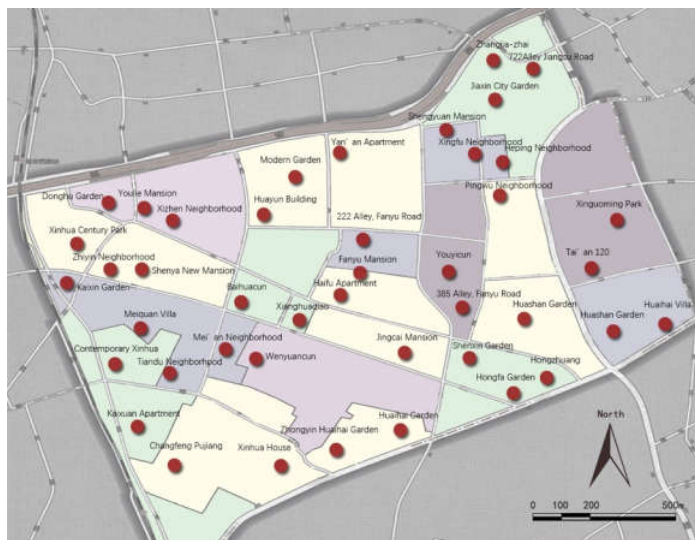
Figure 2. Map of the community